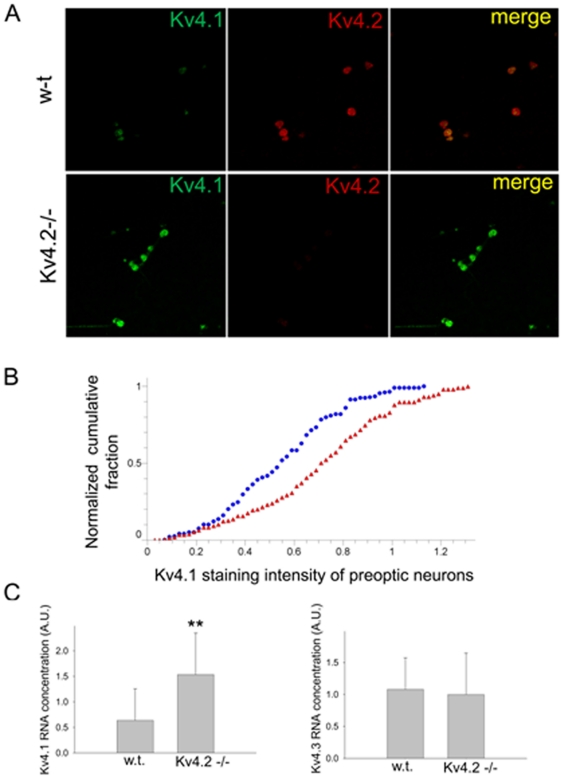
Upregulation of the level of expression of Kv4.1 subunits in Kv4.2−/− preoptic neurons.A. Single channel confocal images showing immunoreactivity to Kv4.1 (Left, green) and Kv4.2 (Middle, red) and their superimposition (Right, merge) obtained from dissociated w-t (upper row) and Kv4.2−/− (lower row) preoptic neurons. B. Cumulative histograms of the Kv4.1 staining intensity in w-t (blue circles, n = 708 neurons) and Kv4.2−/− neurons (red triangles, n = 811 neurons). The distributions were significantly different (P<0.01, Kolmogorov-Smirnov test). C. qPCR analysis of Kv4.1 (left) and Kv4.3 gene (right) expression in preoptic area from w-t and Kv4.2−/− mice (n = 6 mice each). For normalization GAPDH was selected as housekeeping gene. Bars represent averaged normalized concentrations ± SD. ** represents significant differences between w-t and Kv4.2−/− groups P<0.01 (t-test).